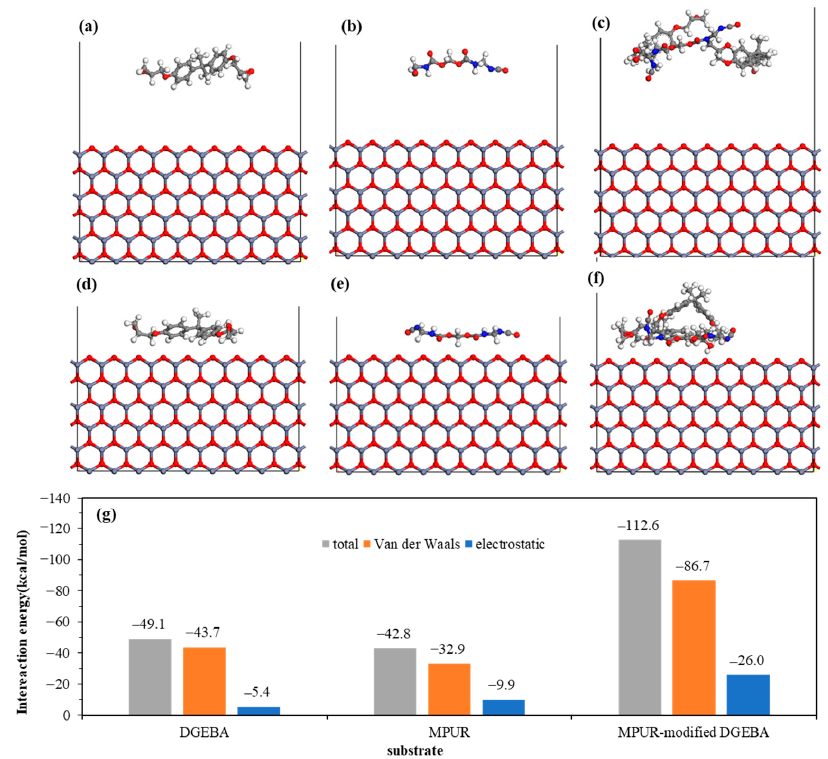
Figure 6. Molecular structure of ZnO(10-10) surface before and after interaction with ( a , b ) DGEBA, ( c , d ) MPUR, and ( e , f ) MPUR-modi fi ed DGEBA, and ( g ) their adsorption energy.